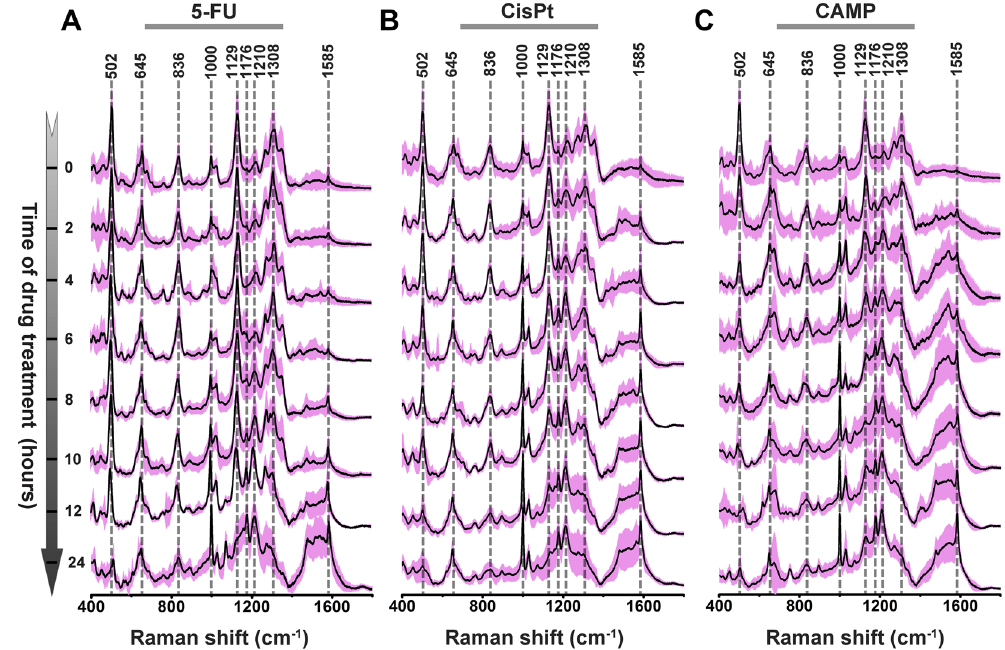
Figure 2. Real-time PERS spectra of cells under the treatment of 5-FU ( A ), CisPt ( B ) or CAMP ( C ). The averaged spectra from 30 trails of spectra were shown as black line and their standard deviation was highlighted as pink